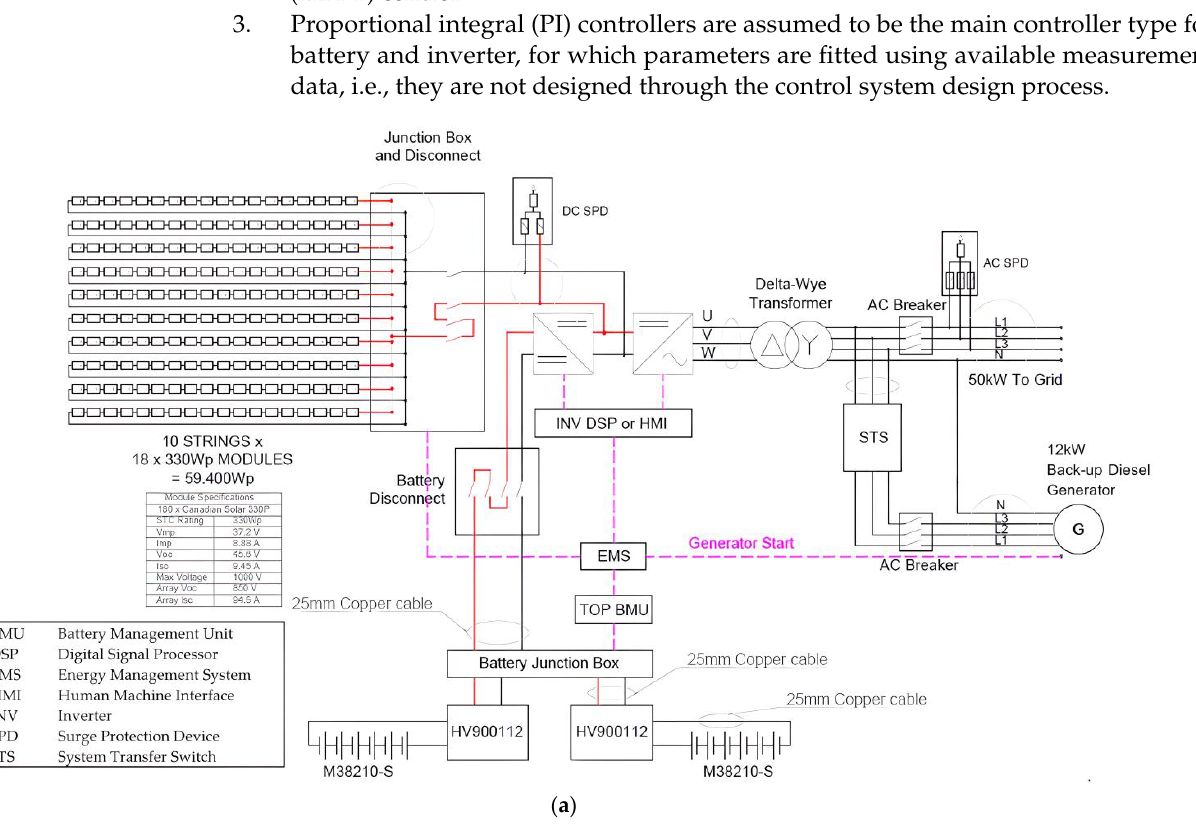
( b ) Figure 1. Mini-grid ( a ) layout; ( b ) single-line diagram (Gionseri B site in Kenya). 3.2. Mini-Grid Model Components 3.2.1. PV Panels The modelled PV array, with total peak power output of 59.4 kWp, consists of a num- ber of interconnected individual PV modules from [17]: 10 parallel strings, each with 18